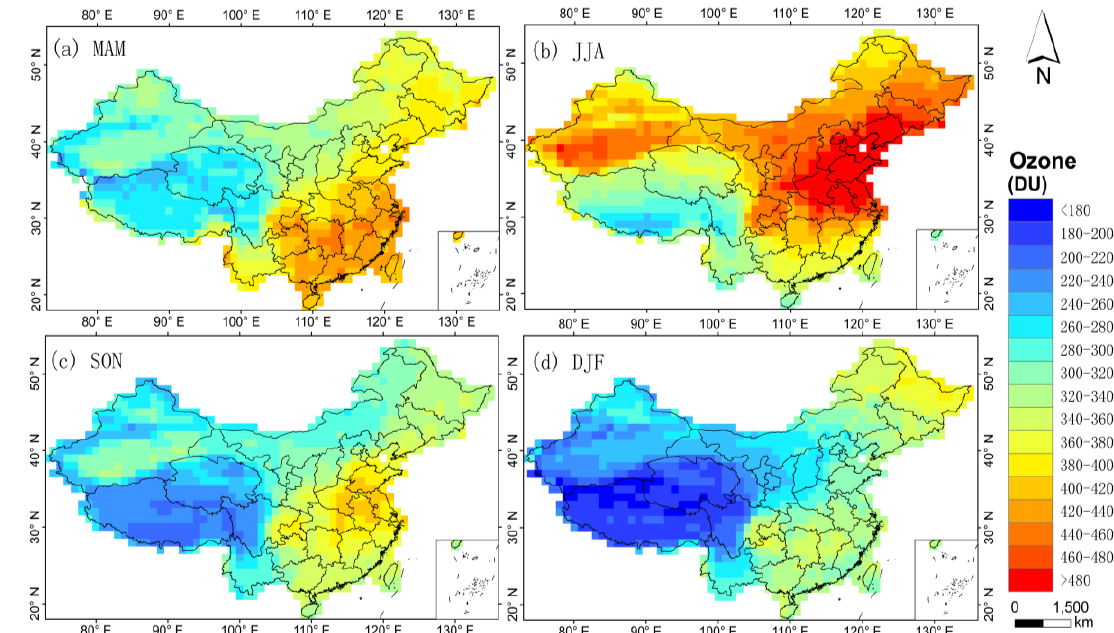
Figure 4. Seasonal variation of tropospheric ozone column over China from 2004 to